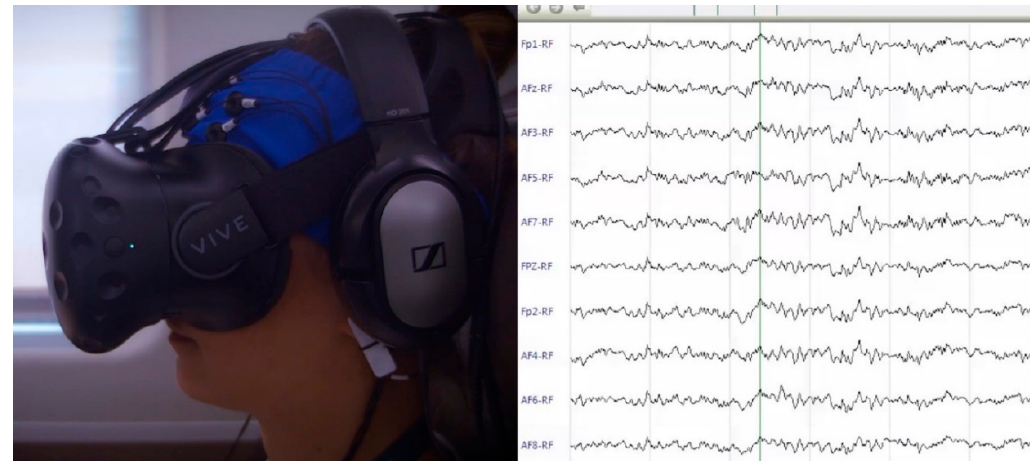
Figure 5. Brain activity (i.e., EEG signal) recording of one participant during virtual high-speed train trip.